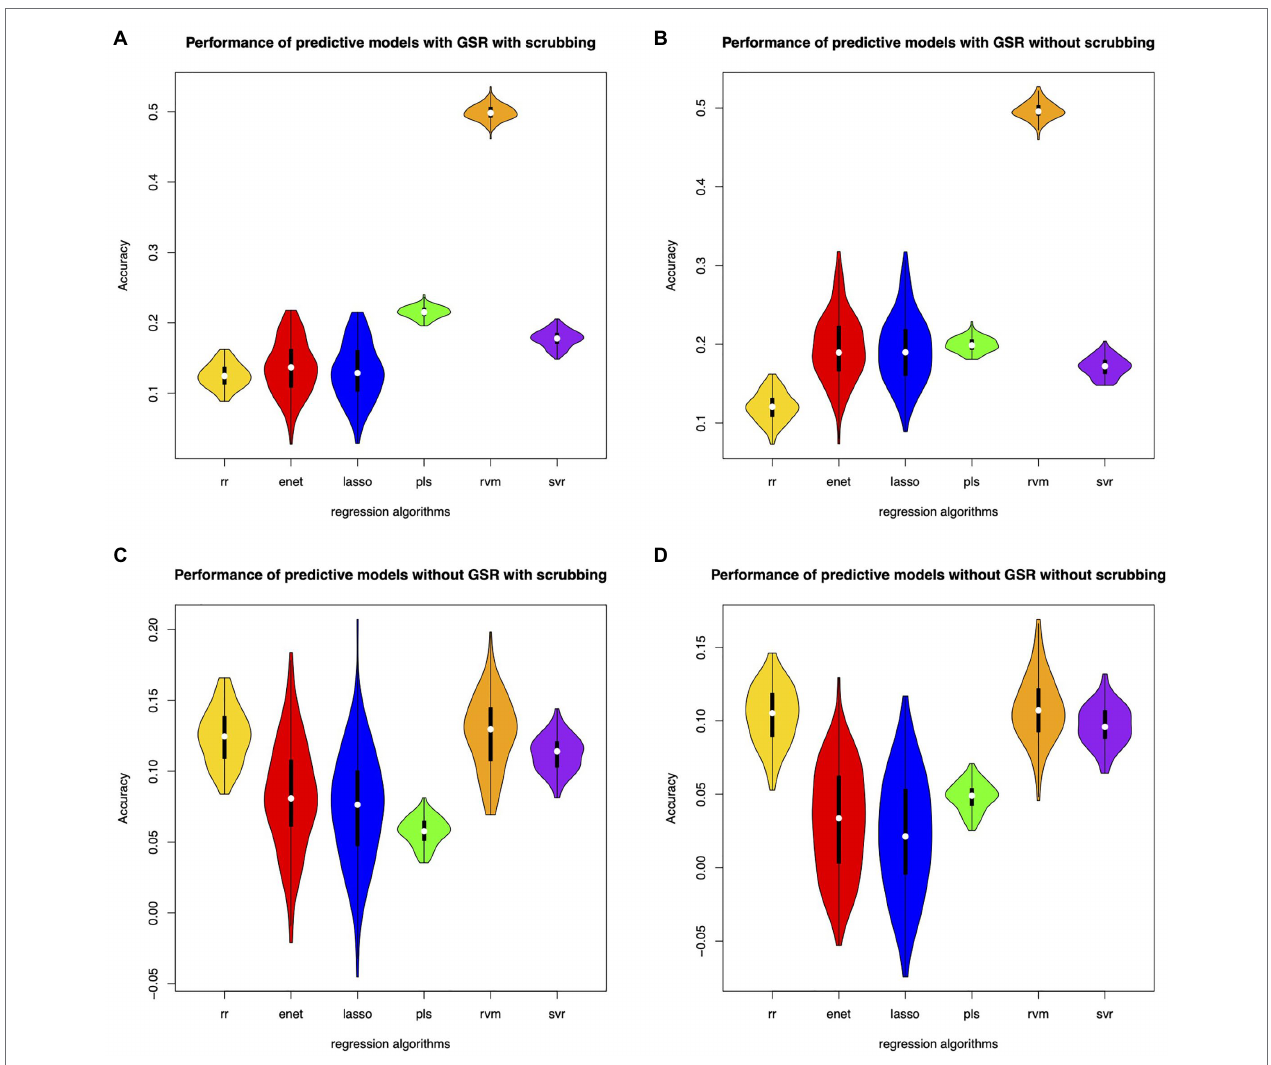
FIGURE 4 | Performance of the predictive models with covariance-based feature selection. (A) denotes performance of the predictive models with GSR and scrubbing. (B) denotes performance of the predictive models with GSR and without scrubbing. (C) denotes performance of the predictive models without GSR and with scrubbing. (D) denotes performance of the predictive models without GSR and